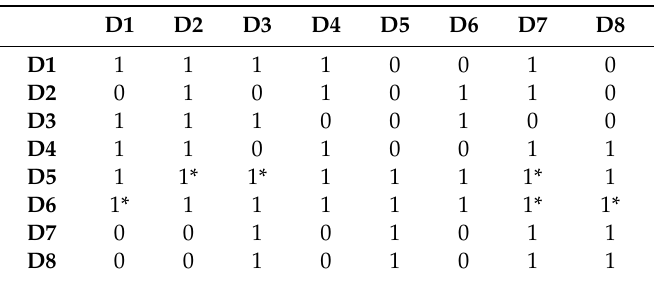
Table 5. Final reachability matrix of drivers of